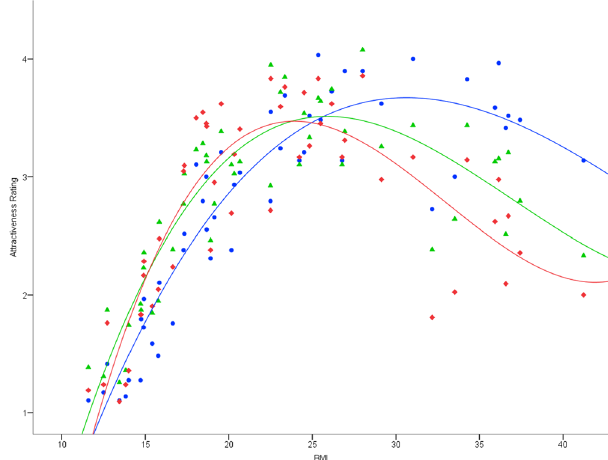
Figure 1. Cubic regression functions for the relationship between stimulus BMI and mean attractiveness rating by location (Village A: red line/lozenges; Village B: green line/triangles; Village C: blue